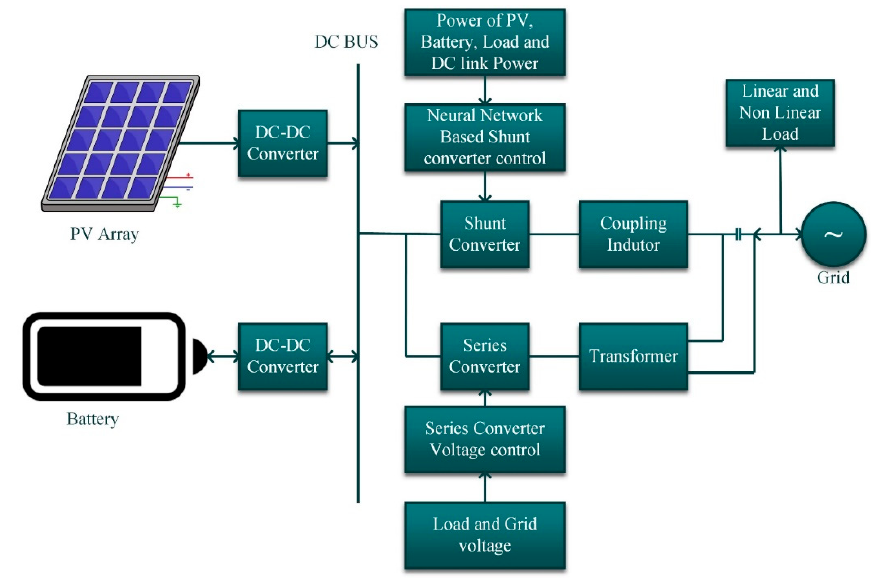
Figure 1. Block Diagram of the Proposed work.